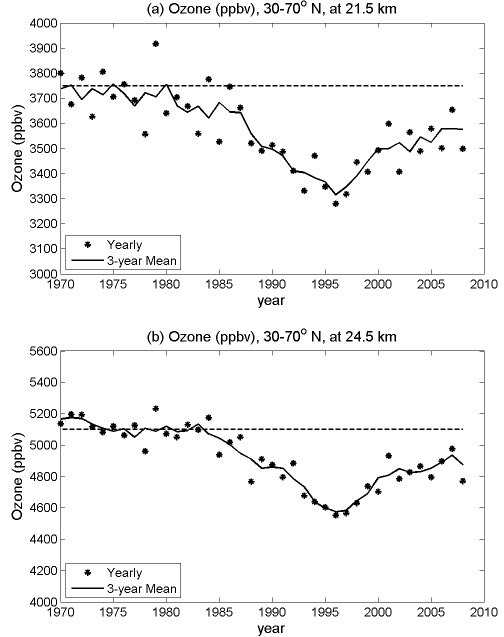
Fig. 15. Annual mean time series at (a) 21.5 km (~50 hPa) and (b) 24.5 km (~30 hPa) averaged over 30-60 N. The solid line is a 3-year running mean and the dashed line indicates the average ozone level before 1980. The area-weighted average is taken using data only from the grid cells where ozone data are available in all years.